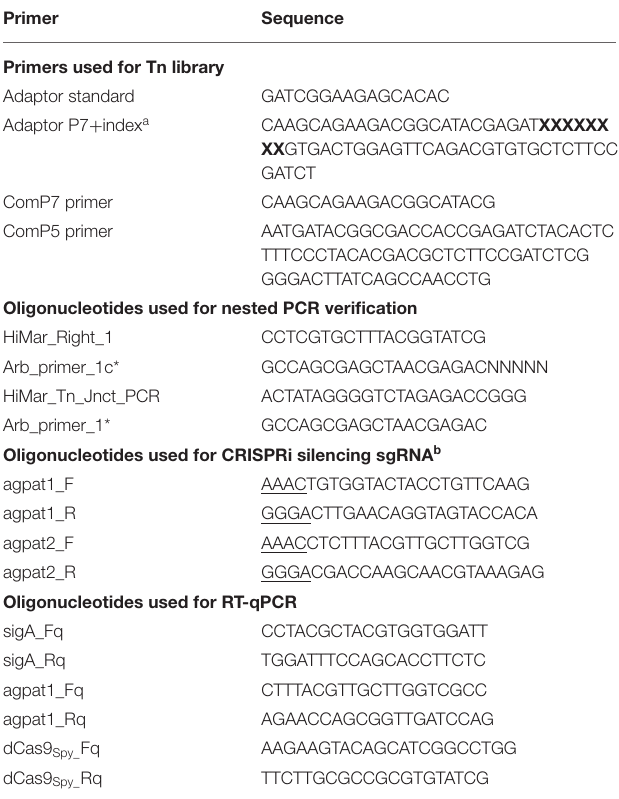
TABLE 2 | Oligonucleotides used in this study. Primer